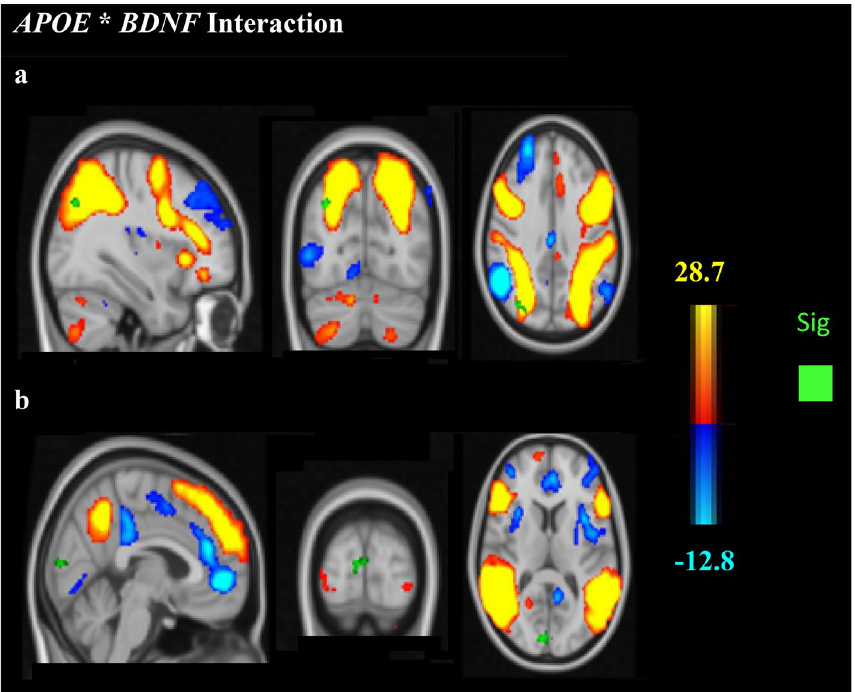
Figure 3. Group-ICA spatial maps of the DAN ( a ) and the dorso-ventral stream/DMN ( b ). ( a ) The findings demonstrate increased connectivity between the DAN and posterior default mode regions (green) in Met/ε3 compared to Met/ε4 (x = 48, y = − 18, z = 2). ( b ) Stronger connectivity was found between the dorsal–ventral stream/DMN and the visual cortex (green) in Met/ε3 carriers than in Val/ε4 carriers (x = 8, y = − 90, z = 8) ( p < 0.05 family-wise error [FWE]-corrected).